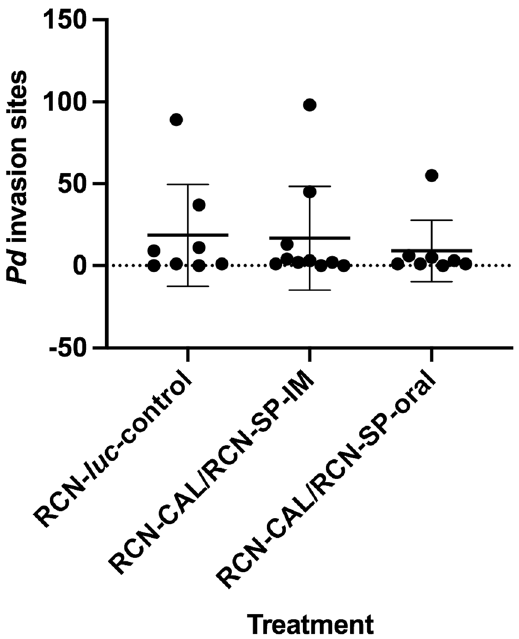
Figure 4. Number of Pseudogymnoascus destructans (Pd) invastion sites evident by histology on the wings of vaccinated and unvaccinated Myotis lucifugus after Pd challenge and